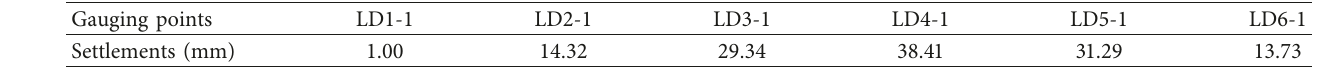
Figure 11: Sensitivity index of E- ν model parameters to settlements in gauging points. Table 3: Measured settlements of gauging points LD1-1 to LD6-1.